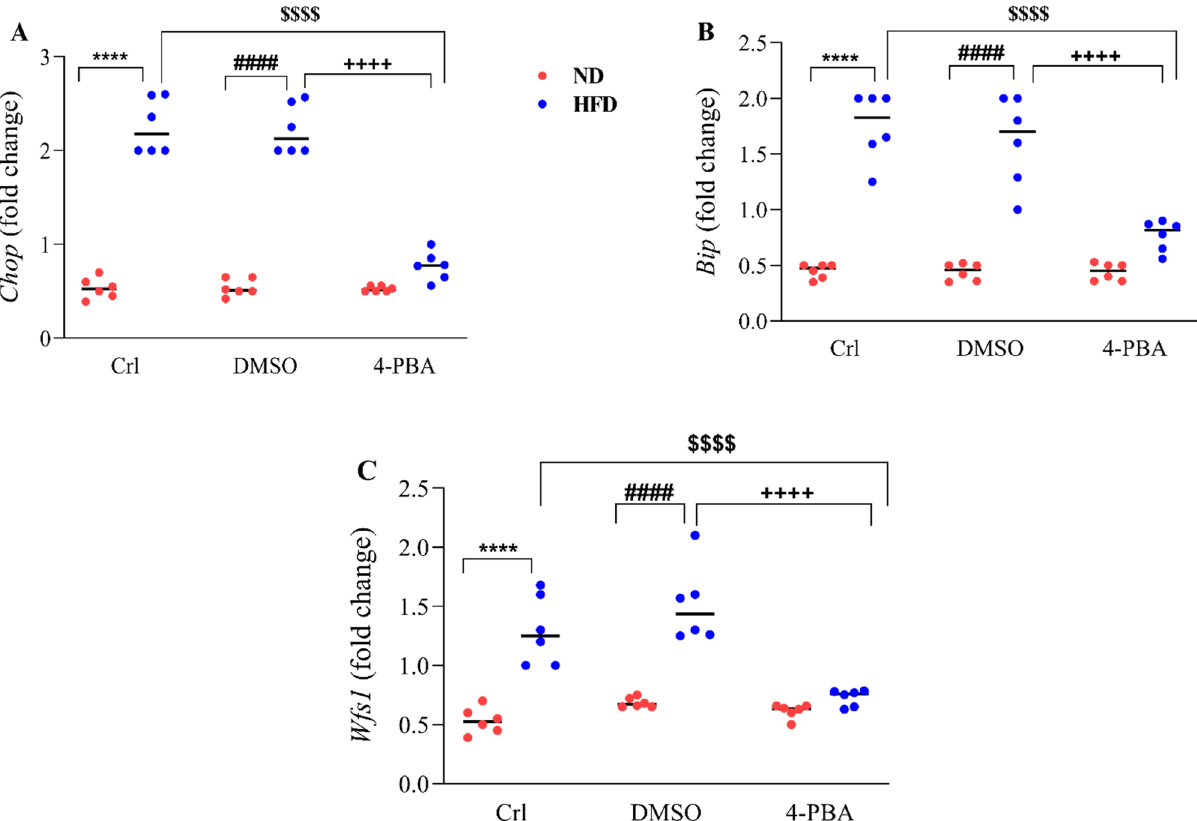
Figure 2. Effect of high-fat diet and/or 4-PBA on pancreatic ( A ) Chop , ( B ) Bip and ( C ) Wfs 1 mRNA levels. Each point represents the mean ± SEM (6 rats/group). ****p < 0.0001 versus control of ND group, #### p < 0.0001 versus ND + DMSO group, $$$$ p < 0.0001 versus control of HFD group, ++++ p < 0.0001 versus HFD + DMSO group. ND Normal diet, HFD High-fat diet, Crl Control, DMSO Dimethyl Sulfoxide, 4-PBA 4-Phenyl Butyric